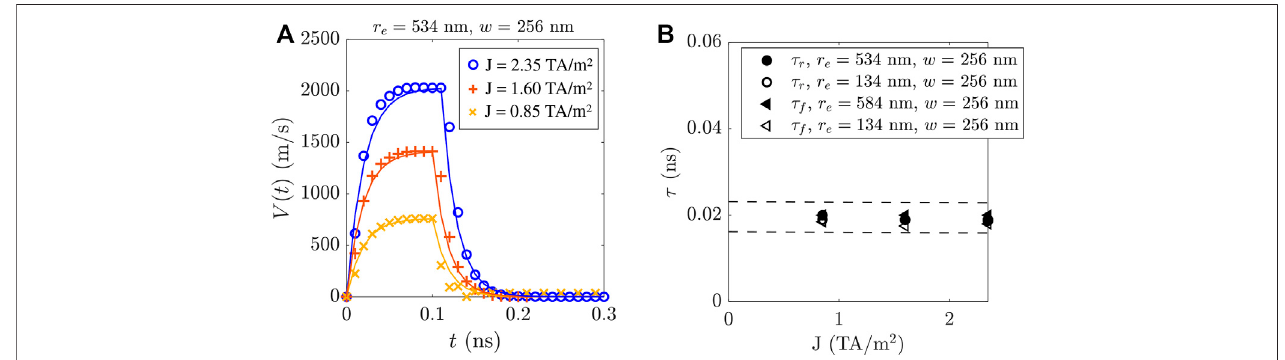
FIGURE6| InstantaneousDWvelocities V ( t )forthreevaluesofJandforacurvedstripof r e (cid:2) 584 nmand w (cid:2) 256 nmat T (cid:2) T A (A) .Symbolsarethe μ mdata,from which τ (rise and fall times) are extracted for the narrowest and widest strips (B) . Dashed lines in (B) are the upper and lower bounds of a 95 % con fi dence interval.